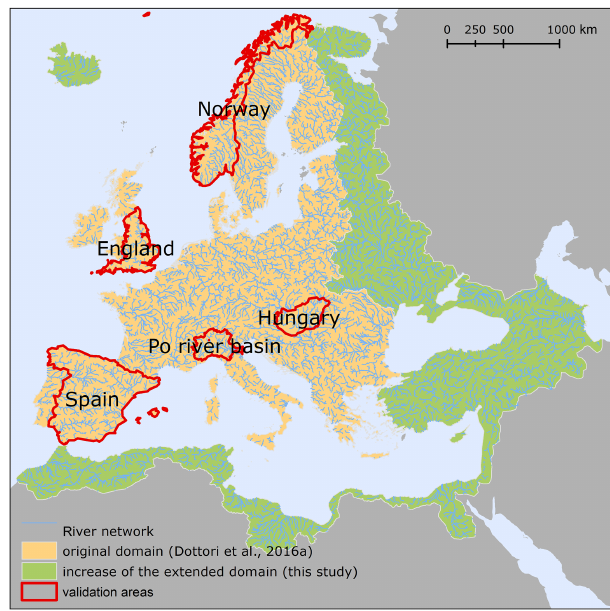
Figure 1. Geographical extent of the EFAS extended domain cov- ered by the present dataset of flood hazard maps. The extent of the map dataset produced by Dottori et al. (2016b) is depicted in beige, while the regions added with the extended domain are in green. The figure also displays the river network considered by the flood maps and the areas used for the validation exercise (see Sects. 2.3 and